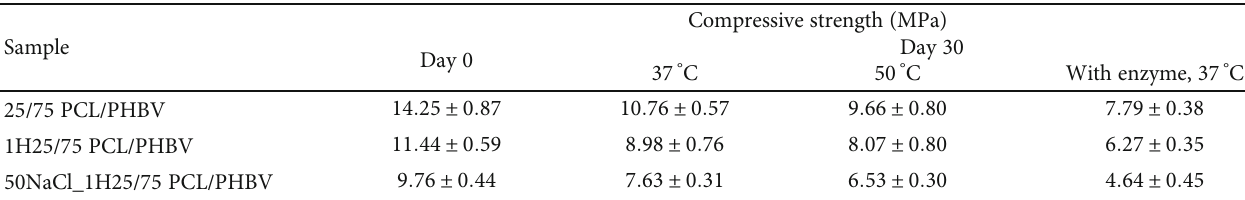
Table 8: Compressive strength of pristine 25/75 PCL/PHBV sca ff old and 25/75 PCL/PHBV with surface modi fi cation and with local pores before and after 30 days of degradation in phosphate bu ff er under di ff erent conditions.